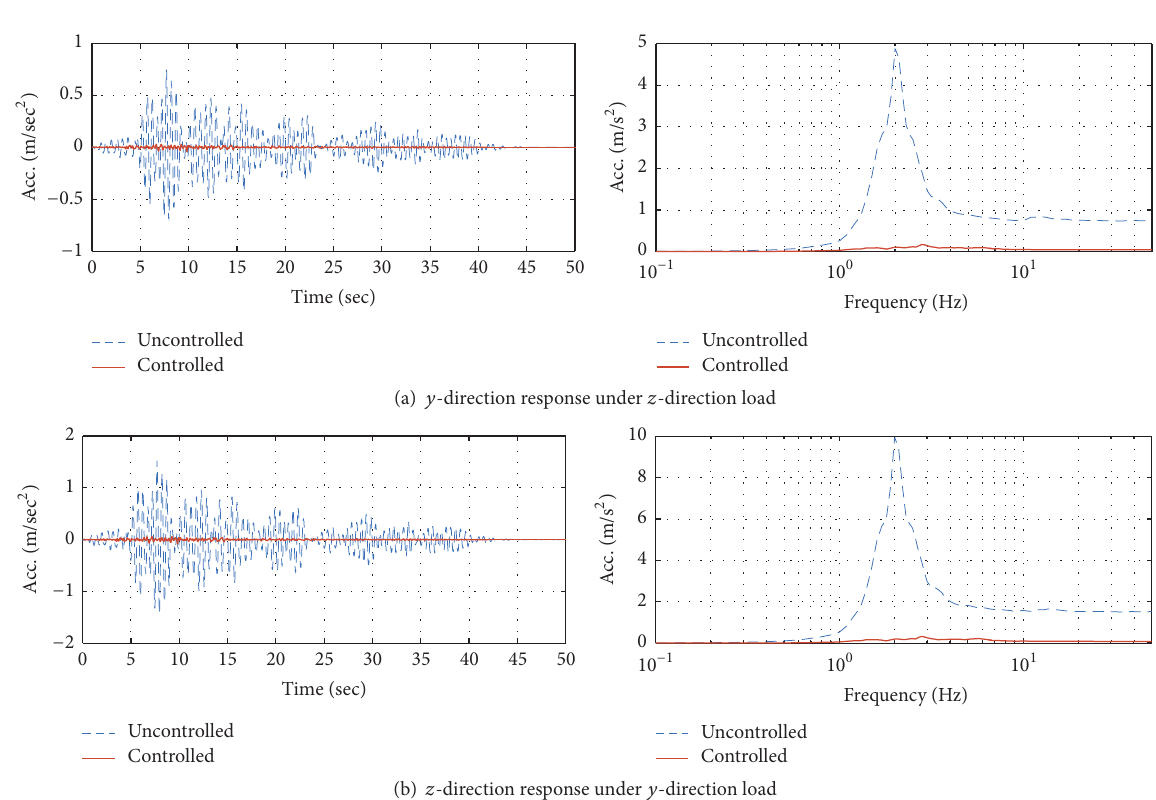
Figure 18: Response of piping system subjected to California